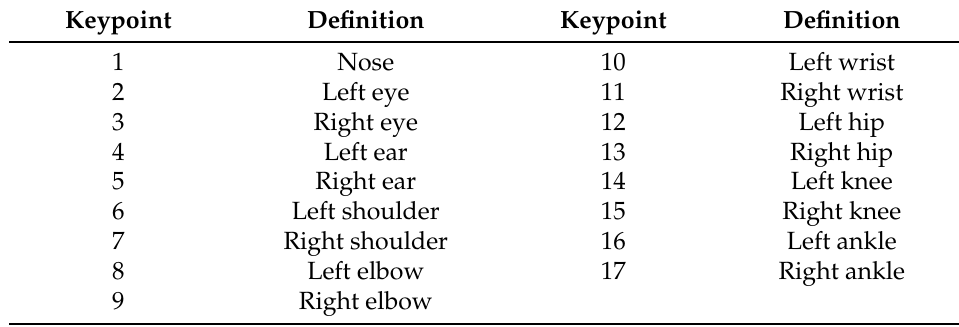
Table 2. Illustrating the definition of macaque